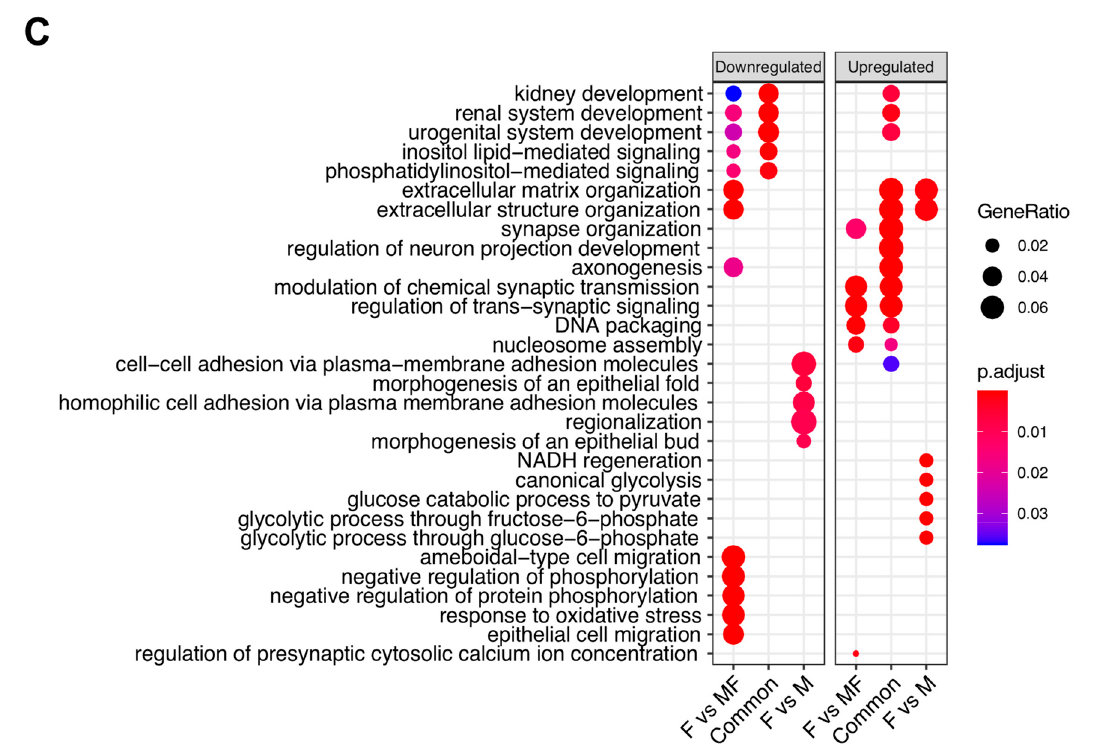
Figure 6. Up and downregulated overlapping genes in fibroid (F) versus matching myometrium (MF) and fibroids (F) versus myometrium from non-fibroid patients (M) Venn diagrams illustrate the overlap for downregulated ( A ) and upregulated genes ( B ) between F vs. MF and F vs. M. ( C ) Top overrepresented Gene Ontology pathways analyses for F vs. MF-specific, shared, and F vs. M-specific up and downregulated genes. Gene enrichment ratio and significance level are shown by the size and color of each circle, respectively.